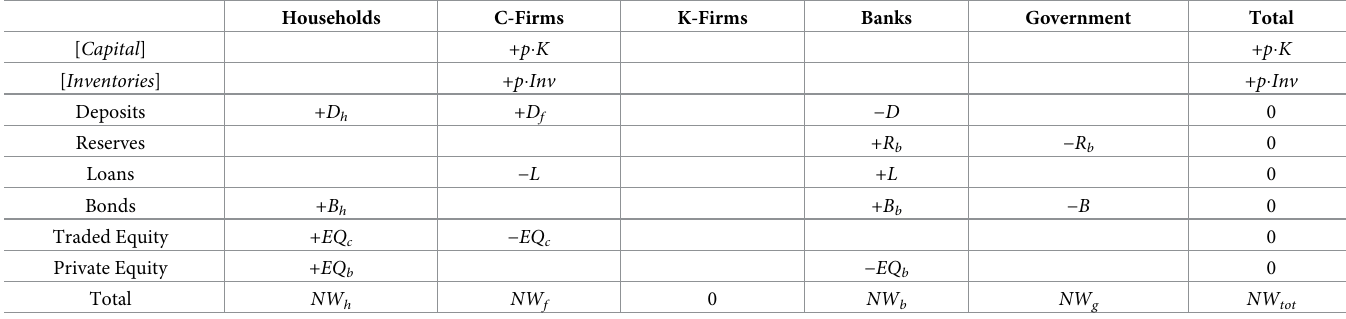
Table 1. Balance